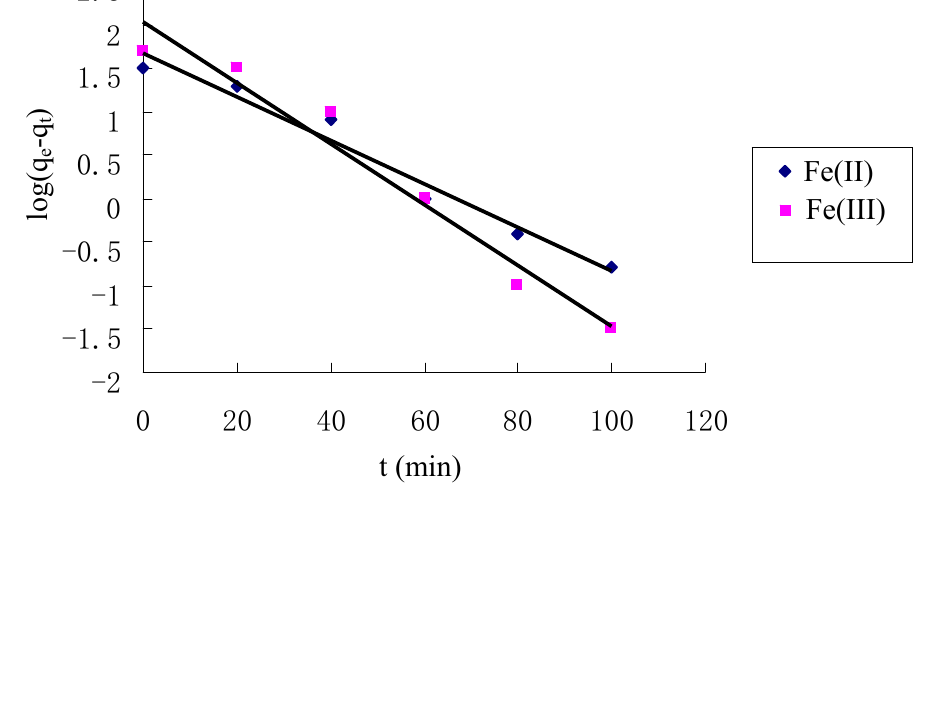
Figure 5. Pseudo first-order kinetic plots for the adsorption of Fe(II) and